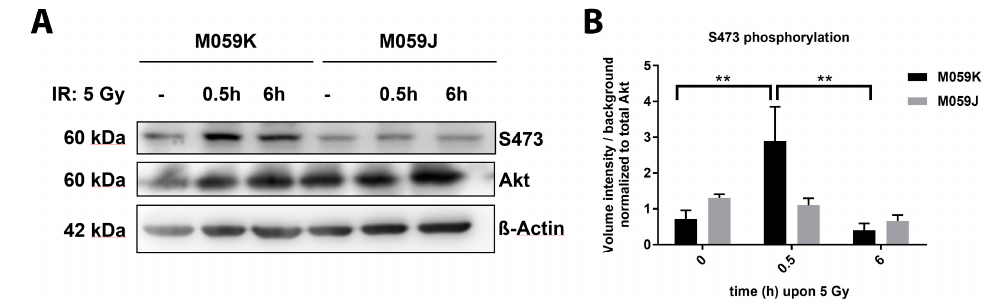
Figure 1. The DNA-PKcs phosphorylates Akt-S473 in cancer cells upon irradiation. Human glioblastoma cell lines M059J (DNA-PK deficient) and M059K (DNA-PK proficient) were exposed to irradiation (IR) with 5 Gray (Gy). ( A ) The phosphorylation (S473) and expression status of Akt was determined by western blot analysis 0.5 and 6 h upon IR and in non-irradiated (-) cells. ( B ) The quantification of pS473 western blots of 3 independent experiments shows the volume intensity normalized to the background. The volume intensity of phosphorylated Akt-S473 was normalized to the volume intensity of the total amount of Akt. The bars show the mean values ± SD of 3 independent experiments ** p < 0.01 ANOVA test with Tukey correction.